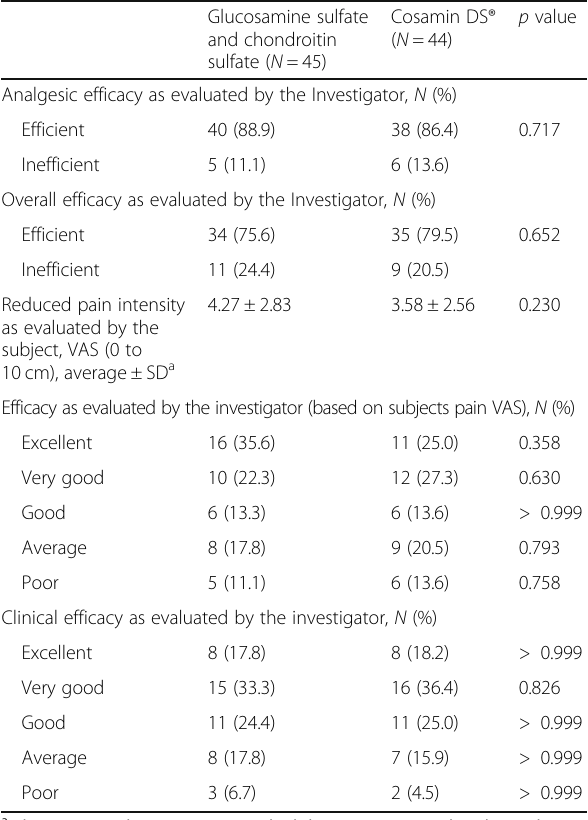
Table 2 Efficacy evaluations at the end-of-treatment visit in ITT population ( N = 89)